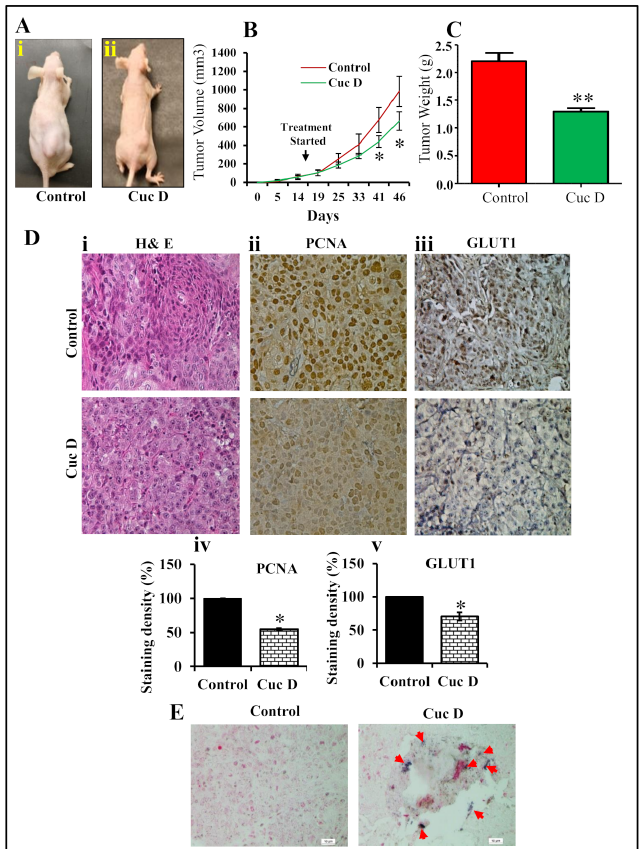
Figure 6. Effect of Cuc D on PrCa cell-derived xenograft tumors in athymic nude mice. ( A ) Representative photograph of athymic nude mice bearing DU145 cells derived xenograft tumors in control ( Ai ) and Cuc D ( Aii ) after 7 weeks. A total of 12 mice were used and divided in two groups: control ( n = 6) and Cuc D ( n = 6). DU145 cells (4 × 10 6 ) were implanted into right flank of each mouse. Cuc D treatment (1 mg/kg) injected 3 days per week after cell implantation and continued until 7 weeks. Control group mice received 0.2 mL PBS. All mice were sacrificed at 7 weeks when control mice tumor reached at targeted volume of ~1000mm 3 . ( B ) Line graph represents regression of xenograft tumors volume in Cuc D treated mice as compared to control group. Asterisk indicate statistical significance determined by Student’s t -test (* p < 0.05). ( C ) Bar graph indicates mean of excised tumors weight of control and Cuc D treated mice. Values in bar graph represent mean ± SE 5 mice tumors in each group. Asterisk indicate statistical significance determined by Student’s t -test (** p < 0.01). ( D ) Illustrative H&E staining images of control and Cuc D treated excised tumors ( Di ). Effect of Cuc D on expression of PCNA ( Dii ) and GLUT1 ( Diii ) in excised tumor tissues of control and Cuc D treated mice as determined by immunohistochemistry using specific antibodies (40 × ). Densitometry analysis of PCNA ( Div ) and GLUT1 ( Dv ). Asterisk indicate statistical significance determined by Student’s t -test (* p < 0.05 and ** p < 0.01). ( E ) Effect of Cuc D on the expression of miR-132 in control and treated mice excised tumors as determined by in situ hybridization (20 ×